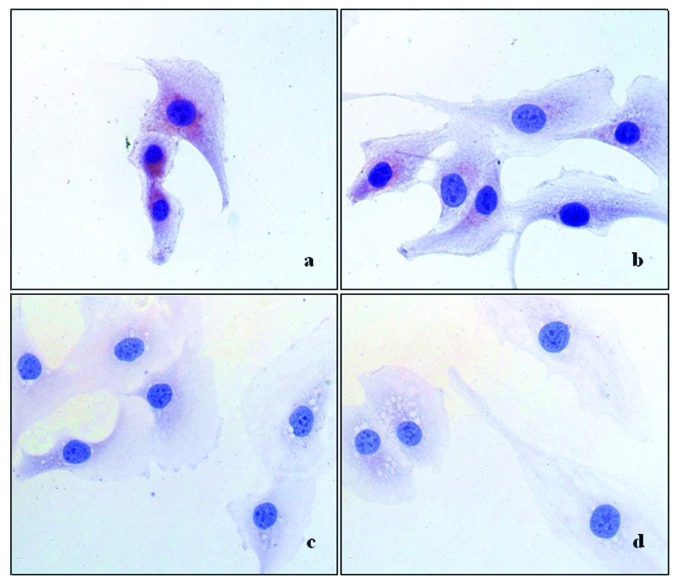
Effect of survivin siRNA on FTC-133 cells as detected using immunocytochemistry. (a) Untreated cells; (b) cells treated with mismatch siRNA; (c) cells treated with sis-100 siRNA; (d) cells treated with sis-248 siRNA